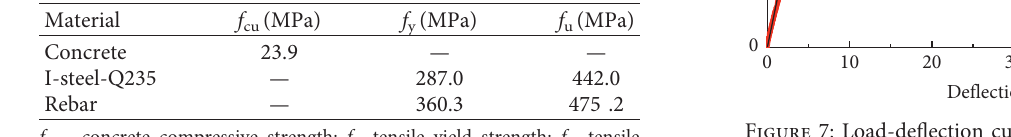
Figure 4: Cross-sectional feature information of the PPEC beam. Table 1: Mechanical properties of materials.